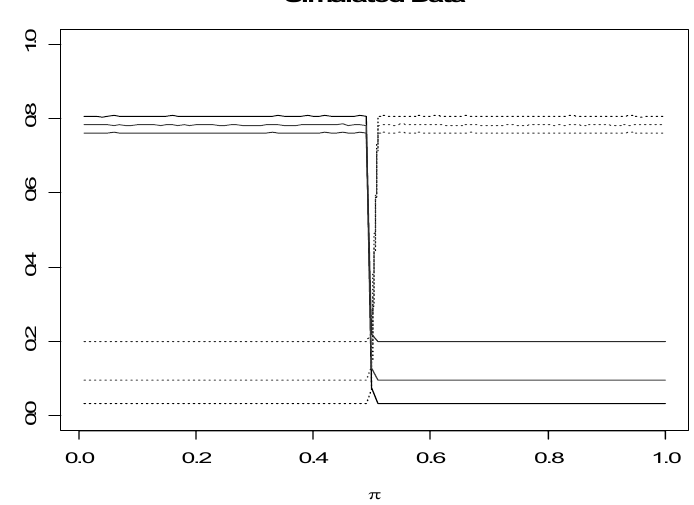
Figure 1 – Results of the optim function with L-BFGS-B minimization algorithm for one data gen- eration. Dotted lines are type I° errors and solid lines represent the powers of each diagnostic test. T 1 = black lines; T 2 = red lines, and T 3 = blue lines. True illness incidence equal to